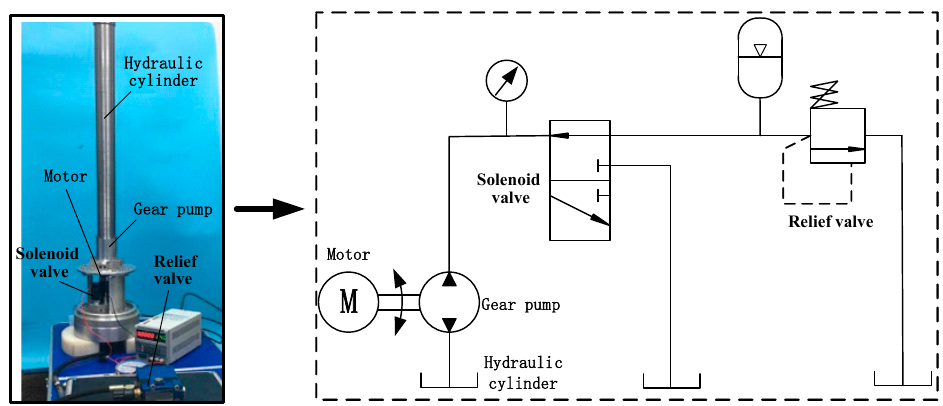
Figure 3. Schematic diagram of the experimental buoyancy regulation system.